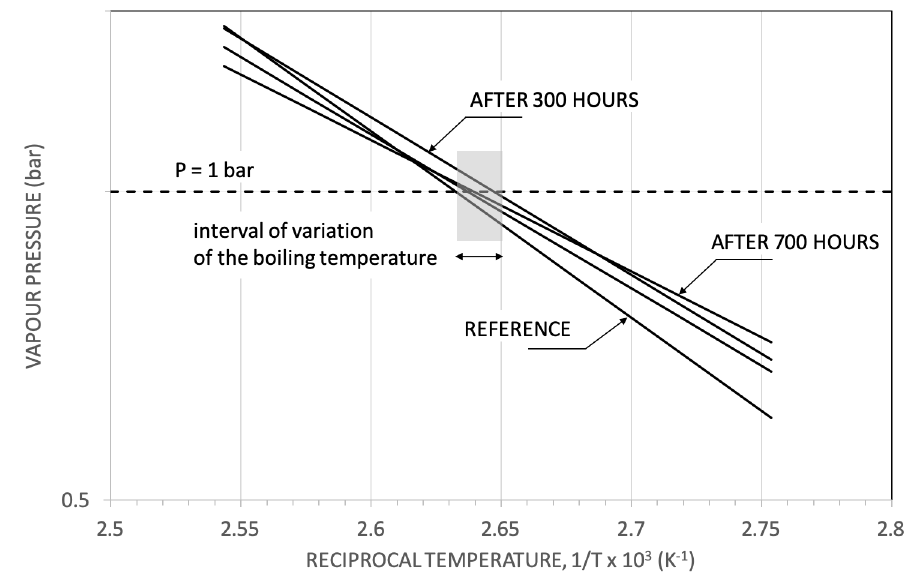
Figure 7. Vapour pressure for a sample of hexamethyldisiloxane (MM) at 350°C after time intervals of 100h